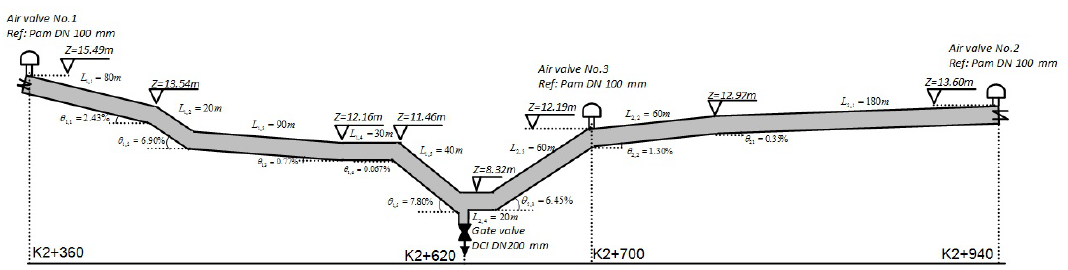
Figure 2. Location of the Ciudad del Bicentenario pipeline.